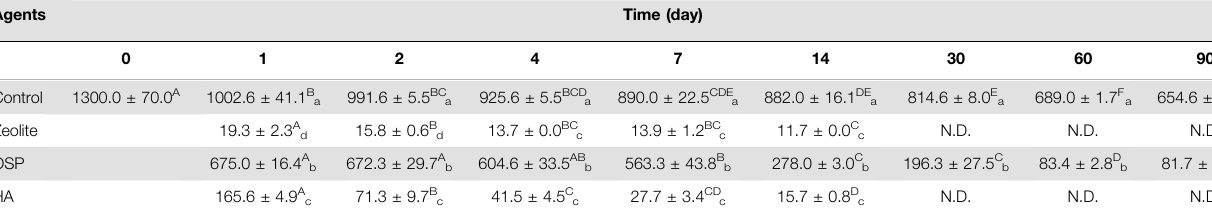
TABLE 1 | Concentrations of MG ( μ g/L) in freshwater after treating with three agents (200 mg/L) at observation point during 90 days. Agents